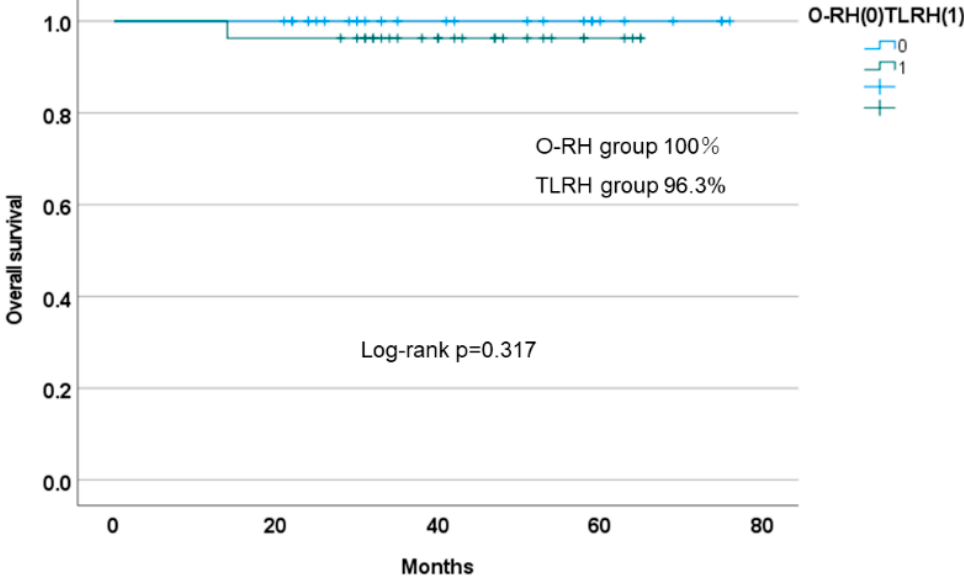
Figure 2. Kaplan–Meier curve for progression-free survival in propensity score-matched patients (TLRH vs. O-RH). O-RH: open-abdominal radical hysterectomy; TLRH: total laparoscopic hysterectomy.